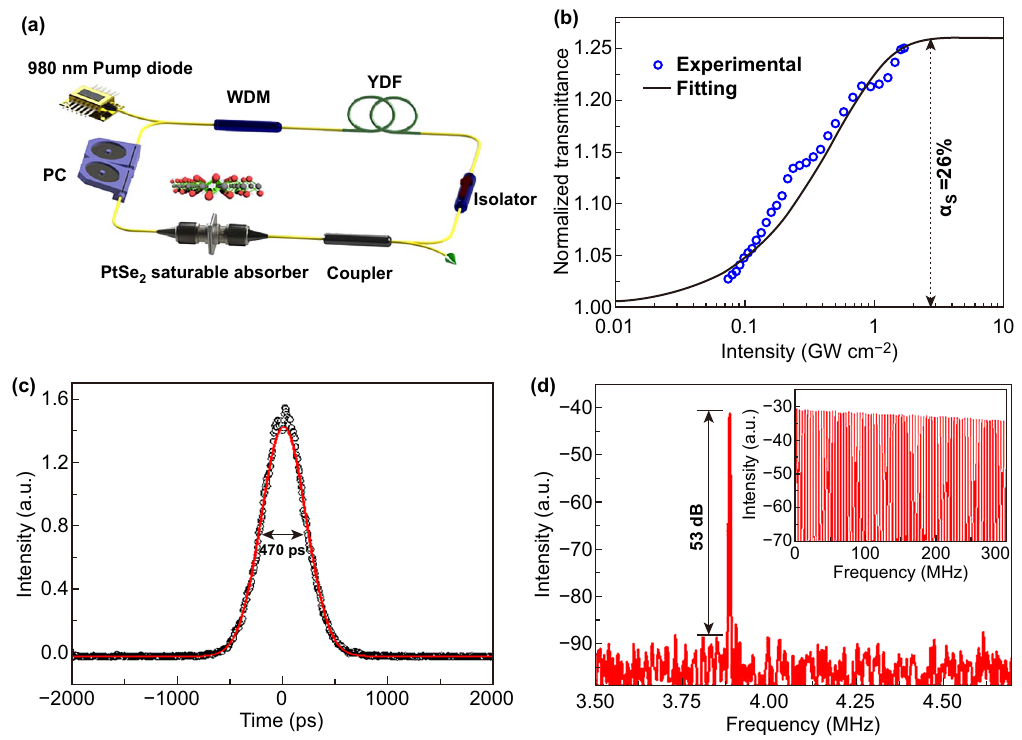
Fig. 11 Mode locker laser of PtSe 2 . a Schematic diagram of the YDF laser ring cavity. PC: polarization controller. WDM: wavelength division multiplex. Isolator: polarization‑independent isolator. YDF: ytterbium‑doped fiber. b Nonlinear transmission curve of 10 nm PtSe 2 saturable absorber. c Single pulse profile indicates the pulse duration. d Radio‑frequency spectrum of the mode‑locked pulses and inset shows the cor‑ responding wideband (0–300 MHz) radio‑frequency spectrum. Reproduced with permission [177]. Copyright 2018, American Chemical